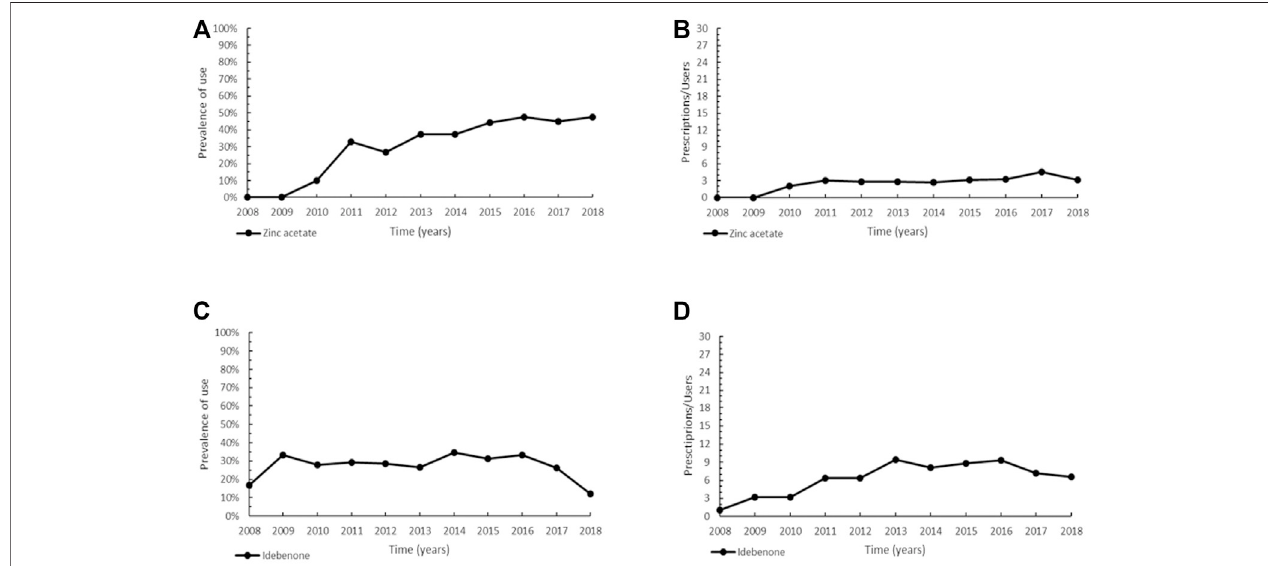
FIGURE 3 | Trend of prevalence (graphs (A,C) ) and intensity of use (graphs (B,D) ) of zinc acetate indicated for Wilson disease and of idebenone indicated for Leber ’ s hereditary optic neuropathy. Prevalence of use: ratio between the number of cases with at least one prescription and the number of prevalent cases at the beginning of each year. Prescription/users: ratio between the number of prescriptions of each medication for the total number of patients with at least one dispensing per